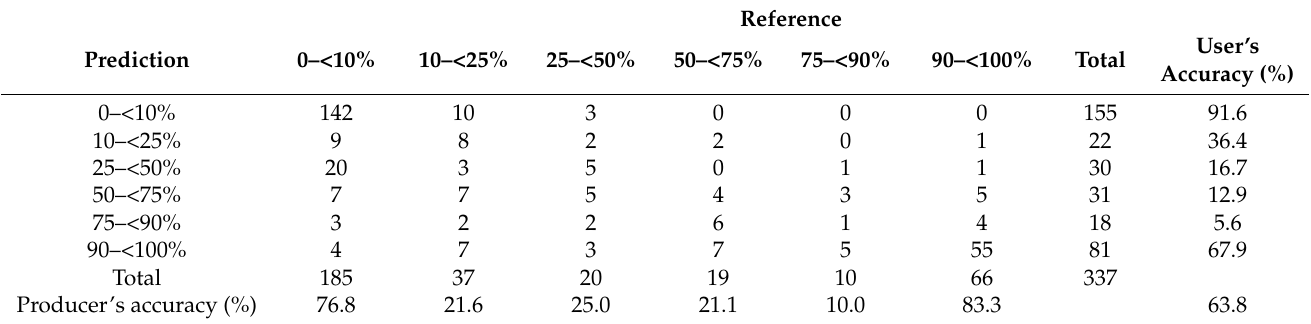
Table A18. Confusion matrix for current (Miller et al., 2009) model predicting EA BA change with Landsat RdNBR with offset.